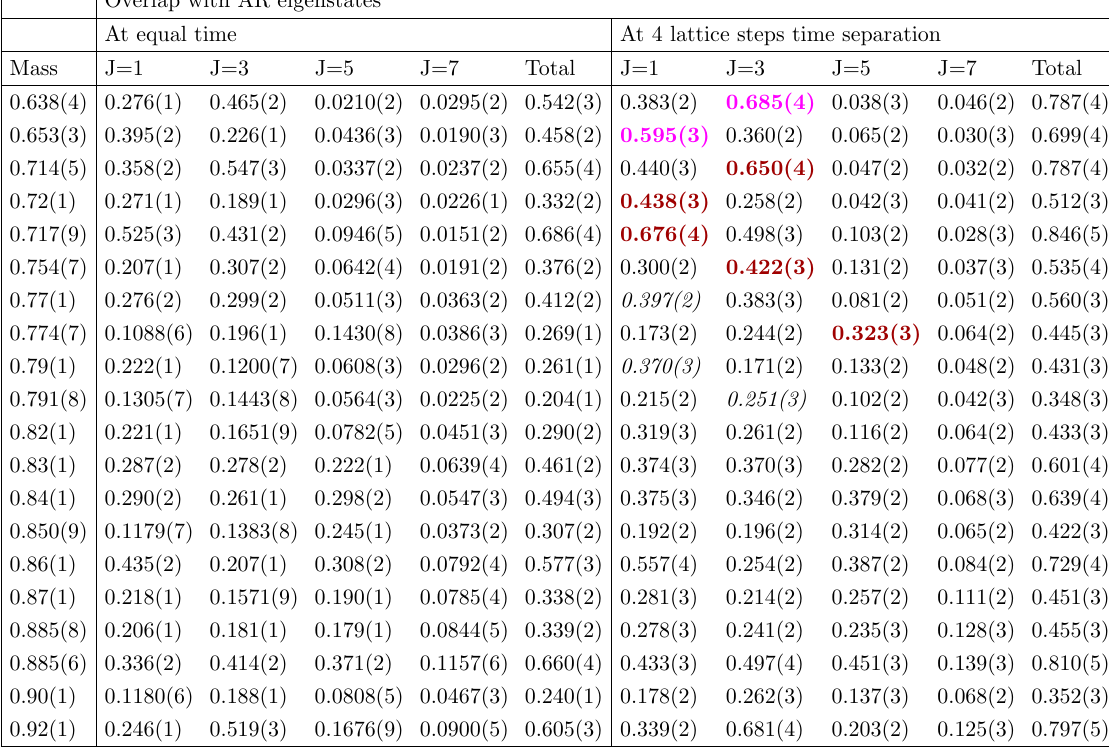
Masses of glueballs in E representation with C = + and averaged over P , using conventional operators and overlaps with AR